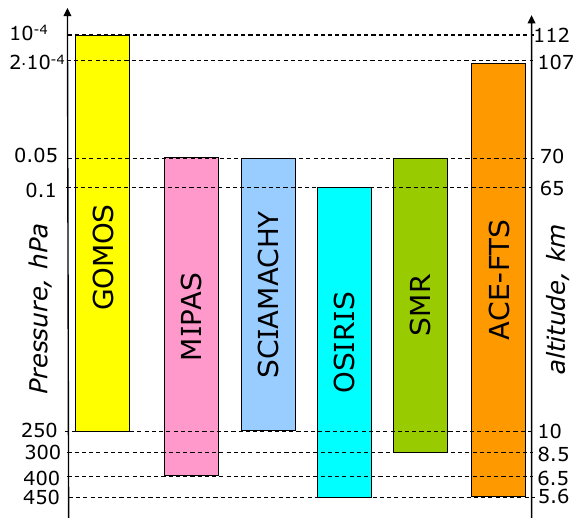
Figure 3. Illustration of altitude ranges of ozone measurements for Figure 3 Illustration of altitude ranges of ozone measurements for the individual in- the individual instruments in HARMOZ. The vertical axis is not to struments in HARMOZ. The vertical axis is not to scale.